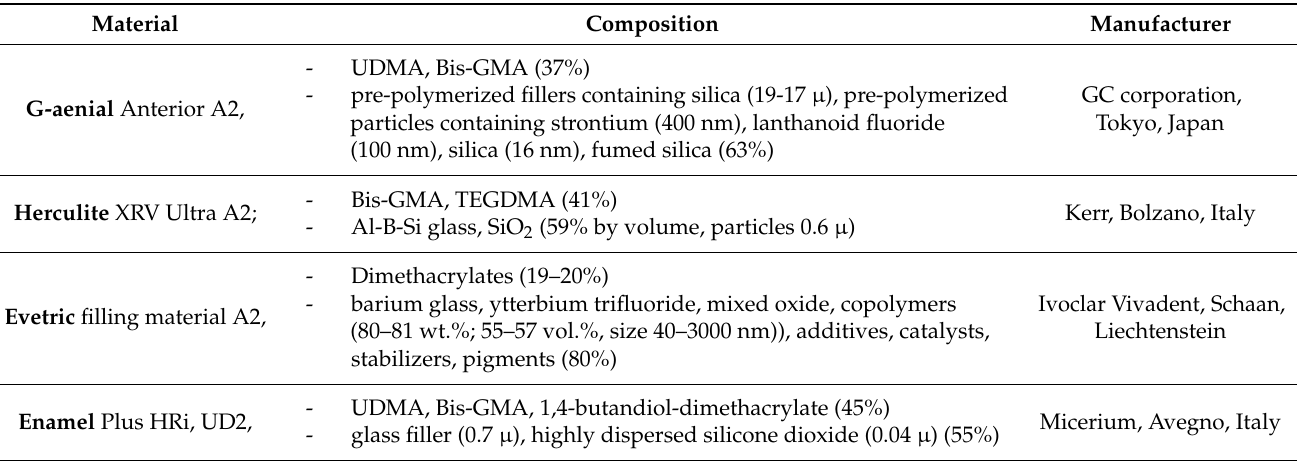
Table 1. Composition of dental composites